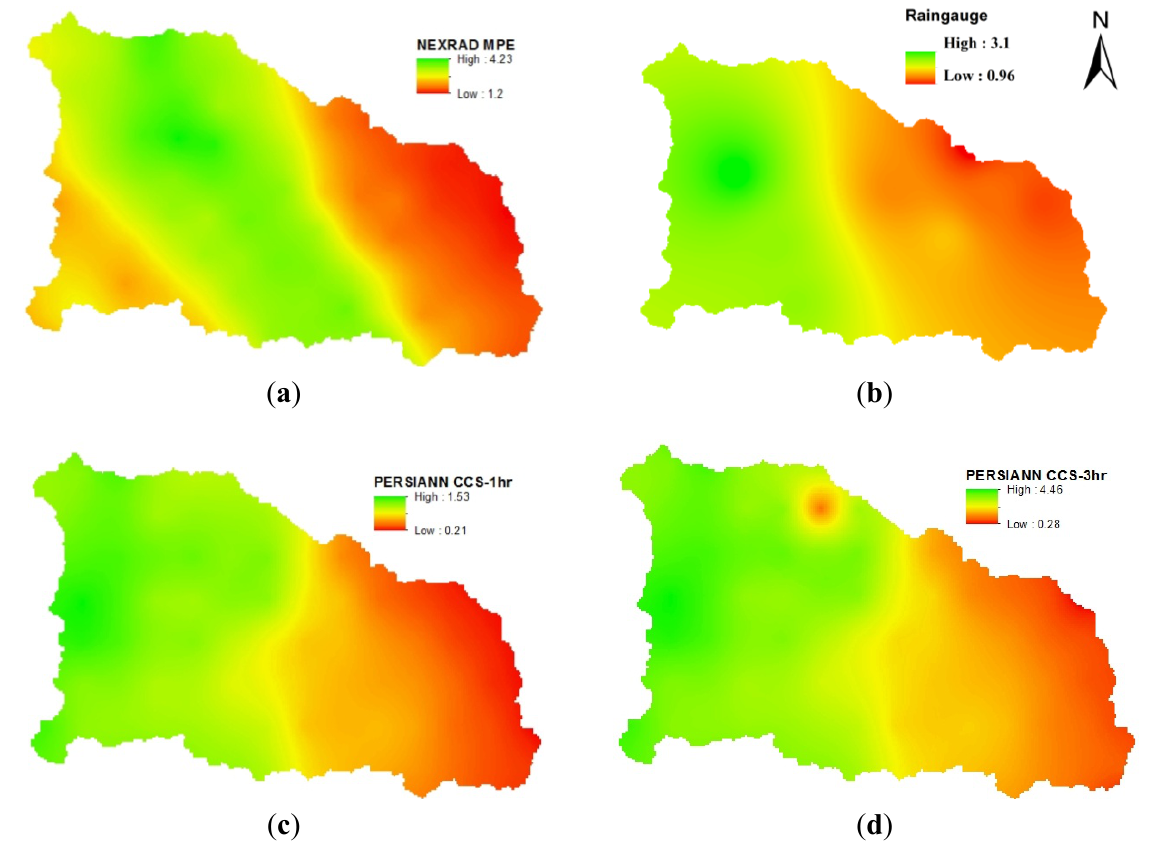
Figure 10. Average precipitation distribution for different precipitation products for the August 2007 event: ( a ) radar; ( b ) raingauges; ( c ) PERSIANN CCS-1hr; ( d )